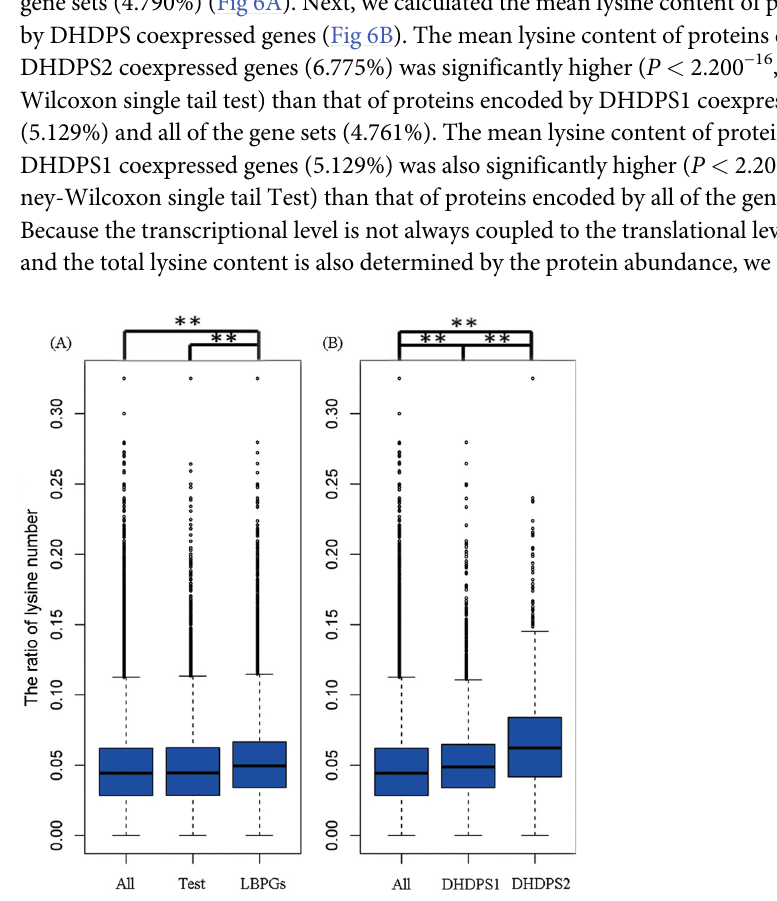
Fig 6. Comparison of lysine content. (A) Comparison of lysine biosynthesis pathway genes coexpressed genes (LBPGs) with the same number of randomly selected all genes set (Test) and with all genes set (All). (B) Comparison of DHDPS1-coexpressed genes (DHDPS1) and DHDPS2-coexpressed genes (DHDPS2) with all genes set (All). ( ** P <